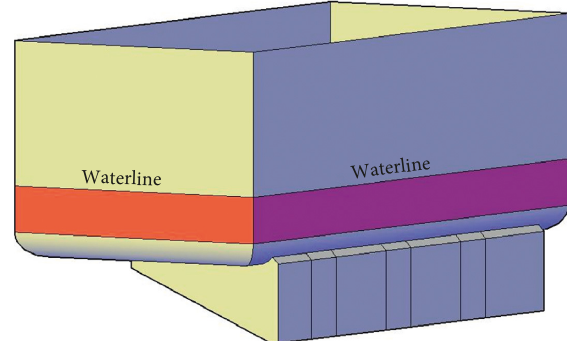
Figure 13: Irregular floating shock platform.